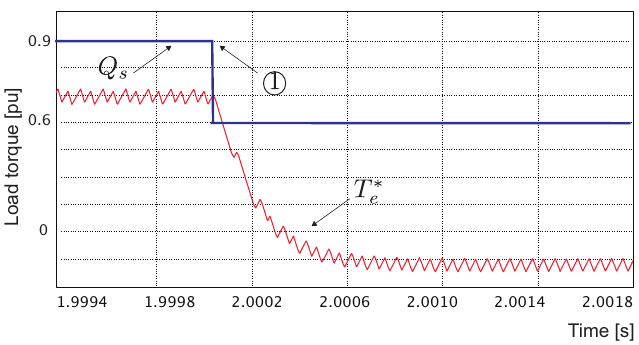
Figure 16. Optimization algorithm step dynamic response.